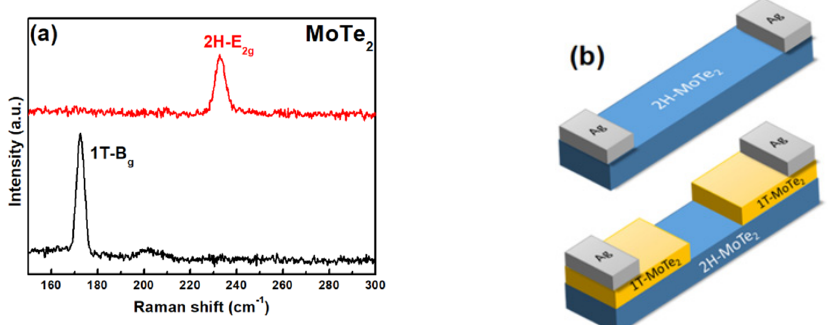
Figure 1. ( a ) Raman spectra of 2H- and 1T-MoTe 2 . ( b ) The schematic diagram of Ag and 1T-MoTe 2 interlayer electrode contacts of 2H-MoTe 2 structures.